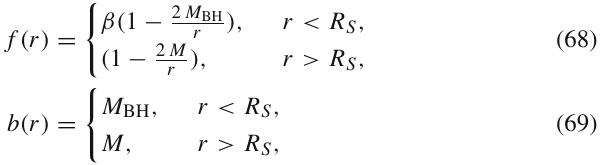
Fig. 6 Radial coordinates of the horizons ( r ± ) and the radial coordi- nates where the tidal forces vanish ( r monopole charge g , for Bardeen-like BHs ( ν = 2) with γ =